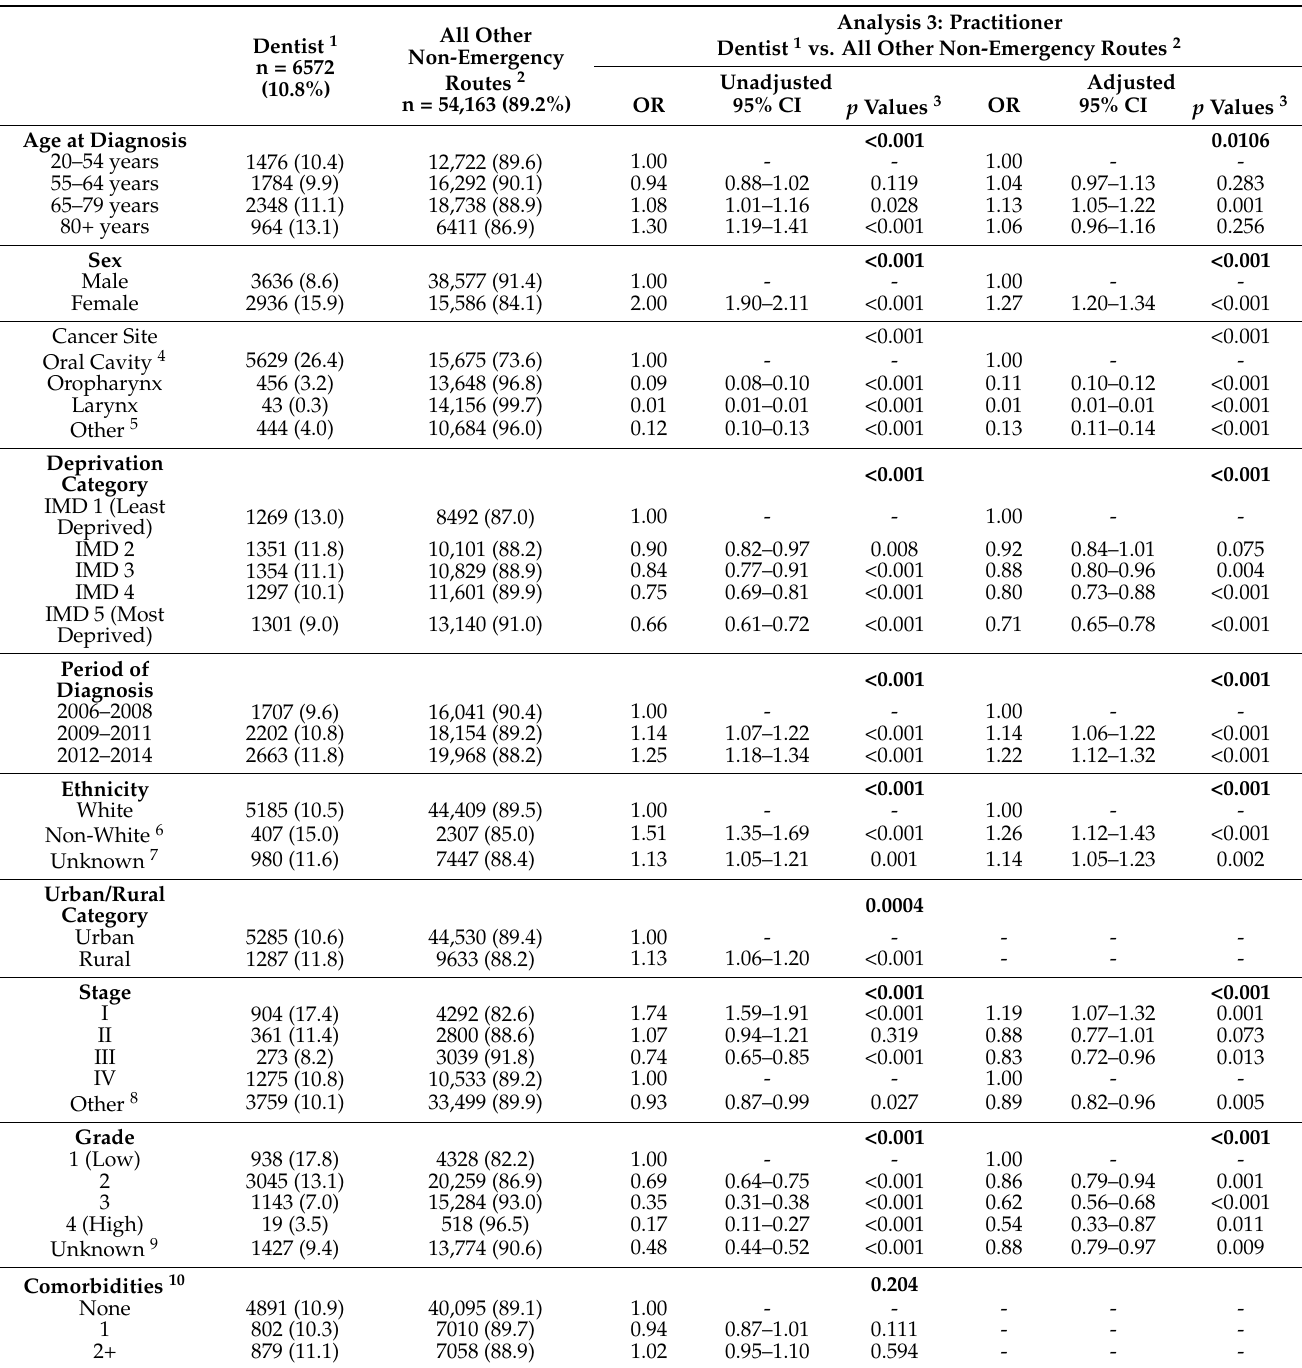
Table 4. Likelihood (OR, 95% CI and p values) from logistic regression of dentist versus all other non-emergency routes by socio-demographic and clinical characteristics for Analysis 3 (n =